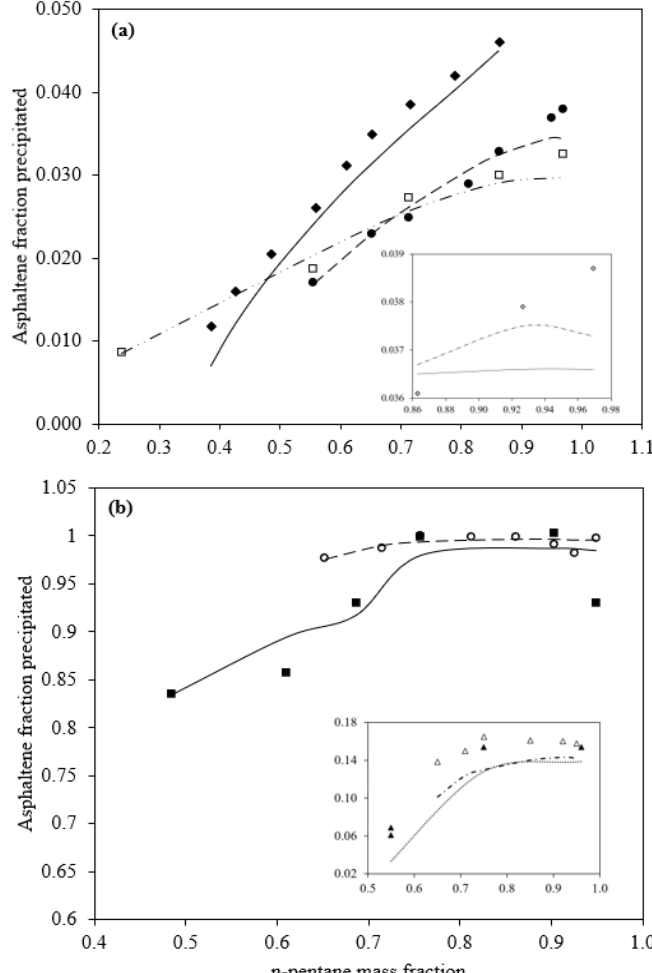
Figure 5. Effect of adding n-pentane solvent on precipitated asphaltene fraction. ( a ) Rassamdana et al., ( ◆ experimental, ━━ calculated), Buenrostro et al., (for oil Y3: □ experimental, ━ ‥ ━ calculated, and for oil C1: ● experimental, ━ ━ calculated), plot inside refers to: Experimental data ( ▲ ) by Hirschberg et al., at 60 °C, (••••) calculated by Victorov and Firoozabadi, and ( ━ ･ ━ ) calculated by Kawanaka et al., ( b ) Wu et al., (for oil Lindberg: ■ experimental, ━ calculated, and for oil Suf- field: ○ experimental, ━ ━ calculated), plot inside refers to Sabbagh et al., (for Athabasca bitumen: ▲ experimental, •••• calculated, and for Cold lake bitumen: △ experimental, ━ ･ ━ calculated).